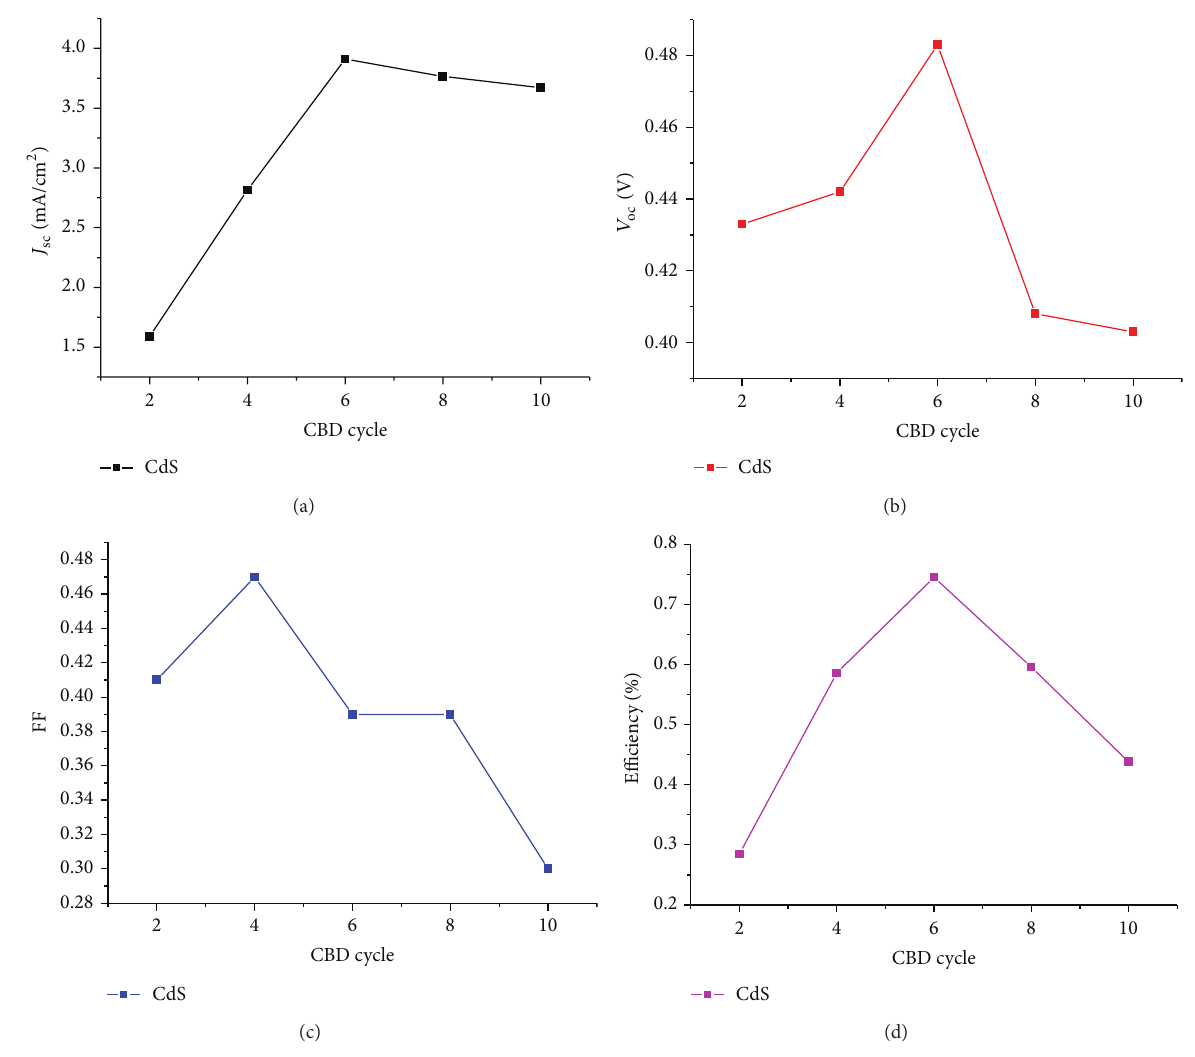
Figure 3: Trend of the 𝐽